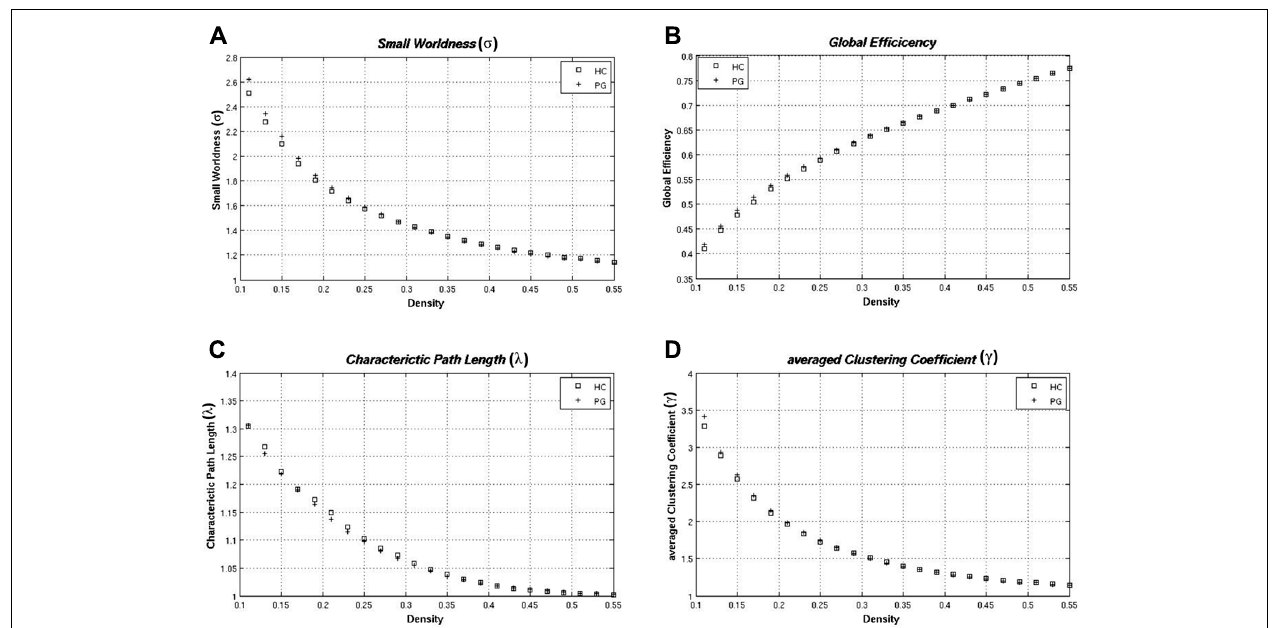
FIGURE 1 | Global metrics for pathological gamblers (PG) and healthy controls (HC) in all density thresholds: (A) small worldness ( σ ); (B) global efficiency; (C) characteristic path length ( λ ); (D) averaged clustering coefficient ( γ ).